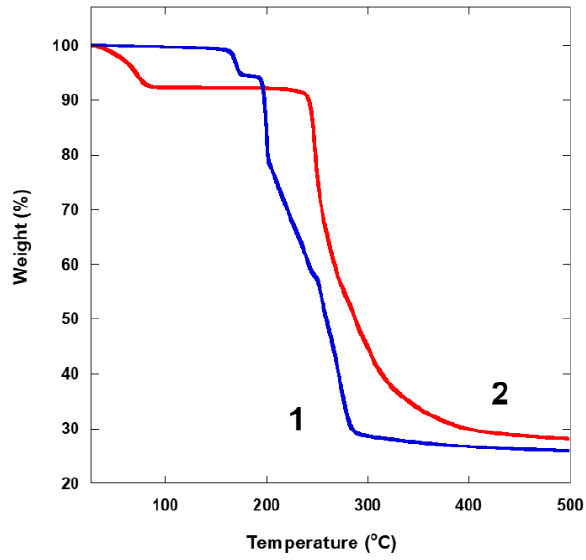
Figure 2. Thermogravimetric analysis (TGA) traces for 1 (blue line) and 2 (red line).